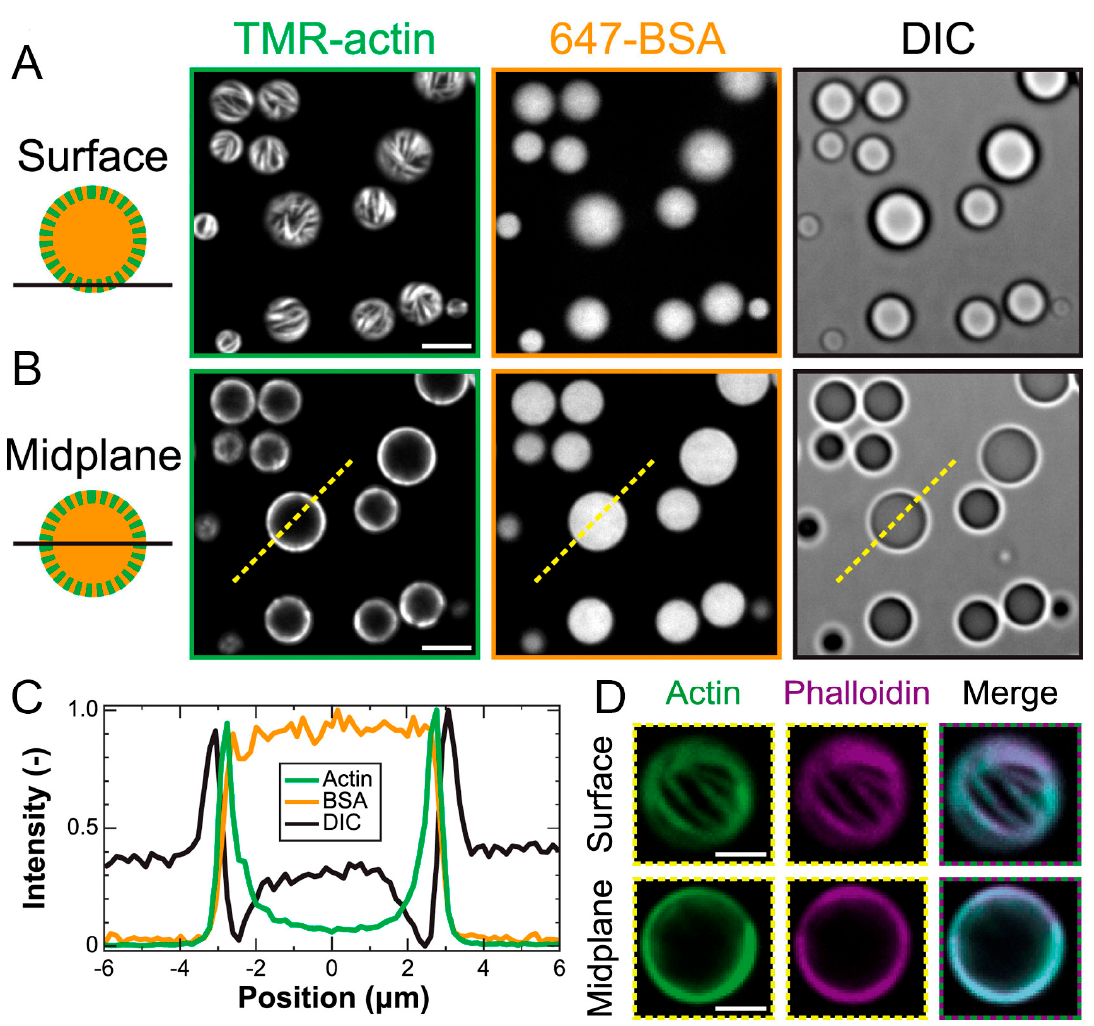
Figure 1. Actin polymerization in the coacervates formed by poly-L-lysine (pLK) and the polyanion poly-(L,D)-glutamic acid (pRE) at the phase boundary. ( A , B ) Microphotographs, obtained using confocal fluorescence microscopy (left and middle) and differential interference contrast (DIC) mi- croscopy (right), show polypeptide coacervates containing TMR-actin (green) and Alexa 647-BSA (orange). The focal plane is at the interface of the coacervates and the substrate (surface ( A )) or near the midplane of the droplet ( B ), indicated by the dashed yellow line. Scale bar, 5 mm. ( C ) Normalized intensity line scans are provided along the dashed yellow lines, as indicated in ( B ). ( D ) False-colored fluorescence images are provided in ( A , B ) from the surface (upper row) and midplane (bottom row). The figure represents panels (A), (B), and (D) of Figure 1 and panels (C) and (D) of Figure 2 from the article McCall et al., Biophysical Journal 114, 1636–1645, © 2018 [18].